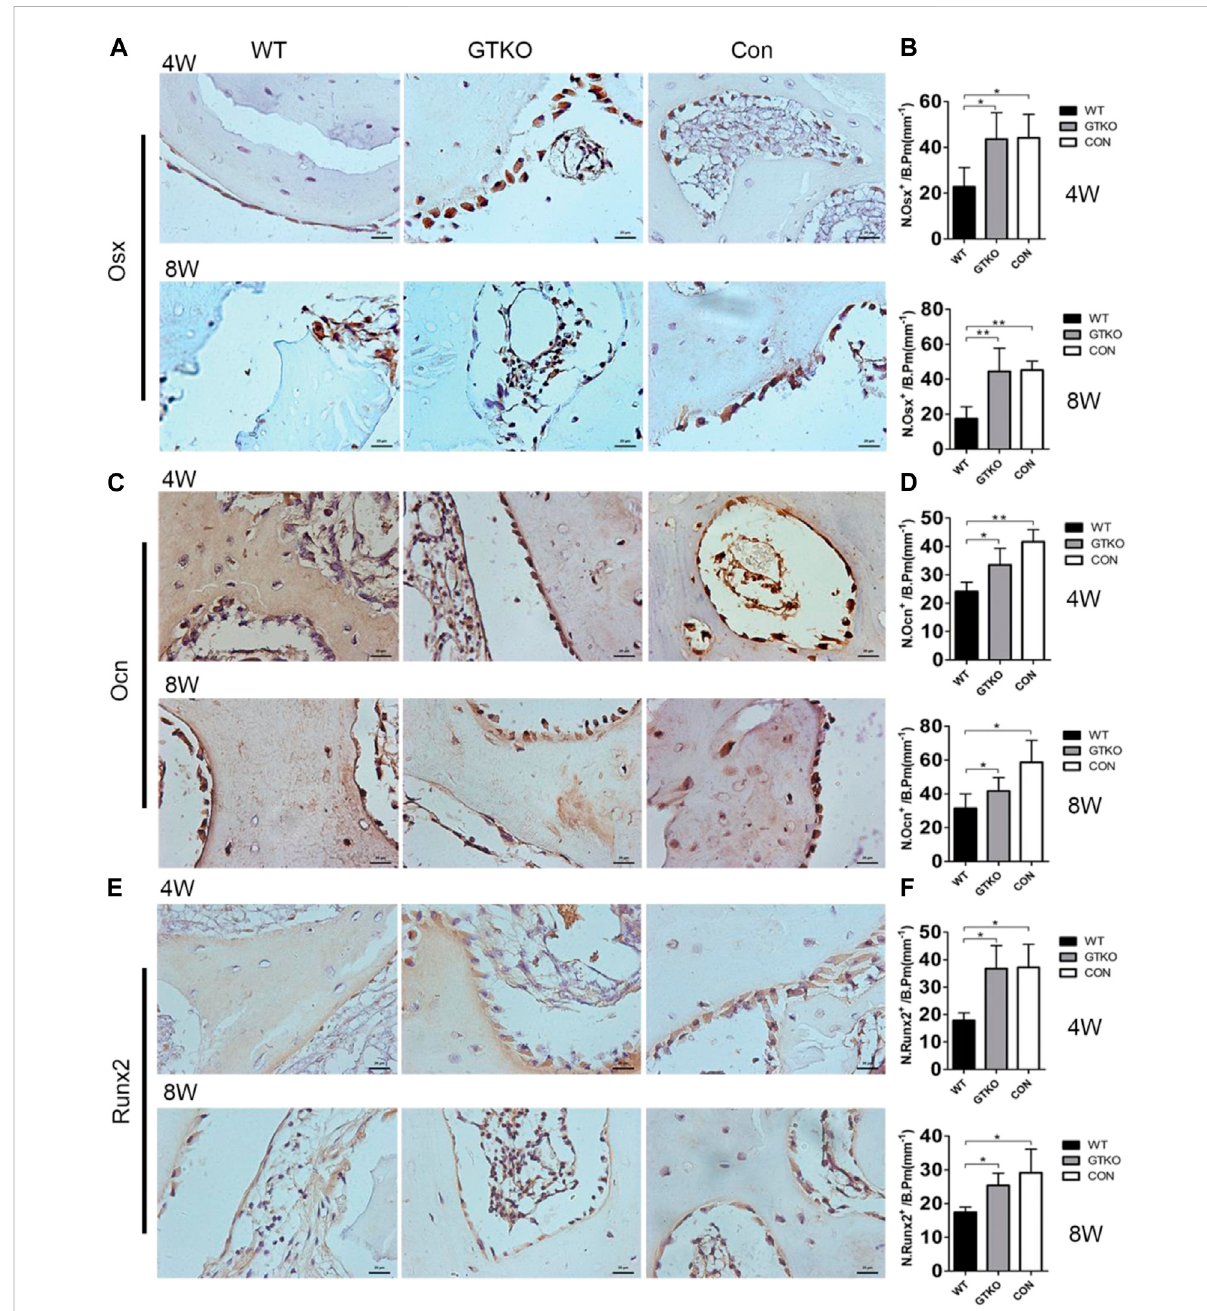
FIGURE 4 Immunohistochemical staining of markers of osteoblast differentiation. (A,B) OSX immunohistochemical staining of the bone defect areas transplanted with the materials shown, 4 and 8 weeks after surgery (×400) and statistical analysis of the number of OSX-positive cells on the bone perimeter(N.Osx+/BPm); (C,D) OCNimmunohistochemicalstainingofthebonedefectareastransplantedwiththematerialsshown,4and8 weeks after surgery (×400) and statistical analysis of the number of osteoblasts on the bone perimeter (N. Ocn+/B Pm); (E,F) Runx2 immunohistochemical staining of the bone defect areas transplanted with the materials shown, 4 weeks after surgery (×400) and statistical analysis of the number of Runx2-positive cells on the bone perimeter (N. Runx2+/B Pm). Scale bar, 20 μ m. Data are shown as mean ± SD. * p < 0.05, ** p < 0.01. Osx, osterix; Ocn, osteocalcin; Runx2, runt-related transcription factor